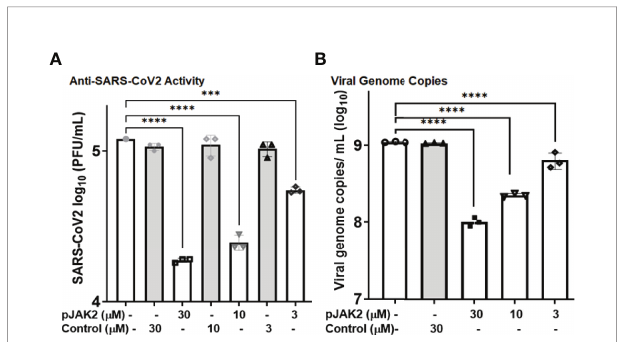
FIGURE 7 | Antiviral activity of pJAK2 against SARS-CoV-2. (A) Calu-3 cells were pretreated with pJAK2 or control peptide at 30 µM, 10 µM, and 3 µM for 2hrs prior to infection. Cells were infected in the presence of the peptides at the indicated concentrations with an MOI of 0.01 with SARS-CoV-2 strain UF 1. Following 1hr of infection, inoculum was removed, and cells were rinsed with PBS. Medium was replaced with peptides at indicted concentrations above. Following 24hrs of infection, supernatant was removed and used to perform plaque assays on Vero-E6 cells. After 72hrs postinfection plaque assays were stained and enumerated. (B) From the same experiment as in (A) , 100 uL of supernatant was removed and used to perform RT-qPCR to detect SARS-CoV-2 RdRp/Hel. ***p < 0.0001; ****p <